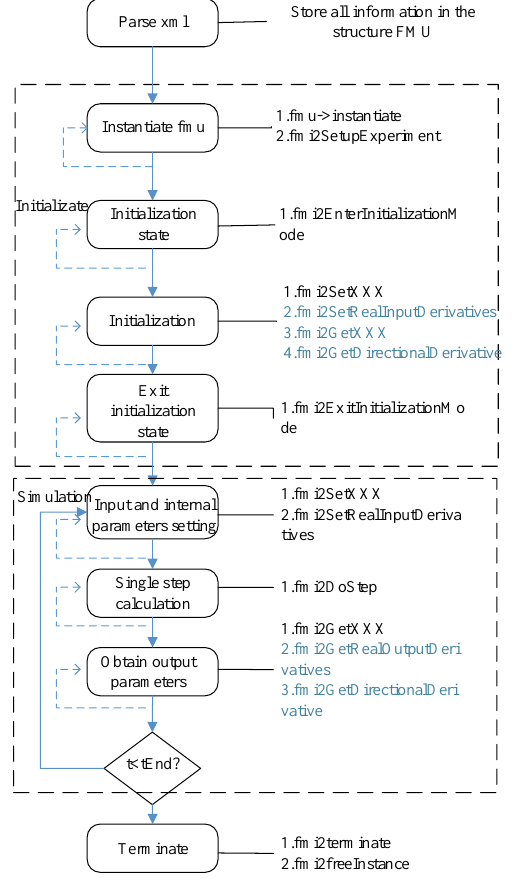
Figure 26. FMU simulation process.